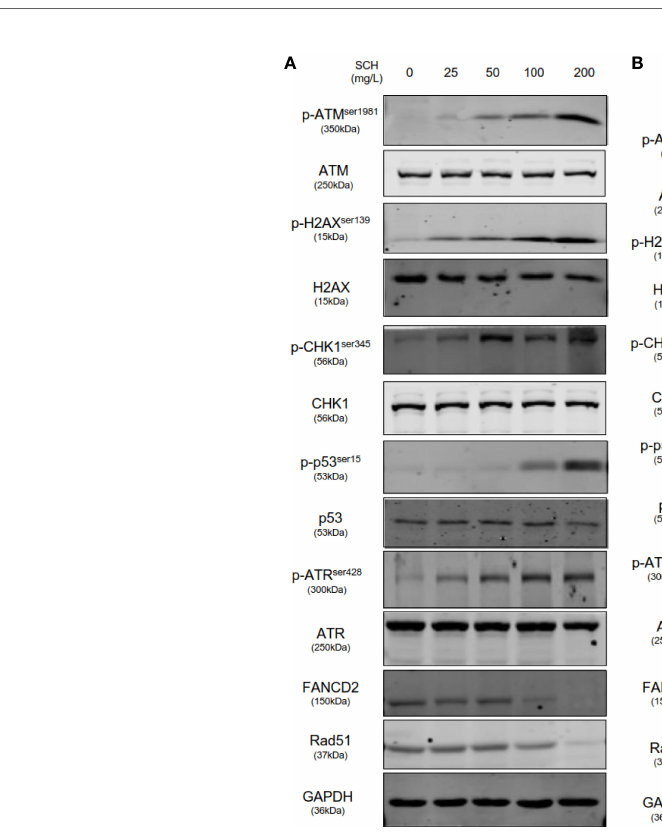
FIGURE 7 | SCH and its key ingredients, quercetin and b -sitosterol, activate DNA damage response pathways and suppress DNA repair pathways. MDA-MB-231- whole-cell lysates administrated with varying concentrations of SCH (A) , quercetin and/or b -sitosterol (B) for 24 h were obtained and subsequently subjected to immunoblotting analysis and explored with the designated